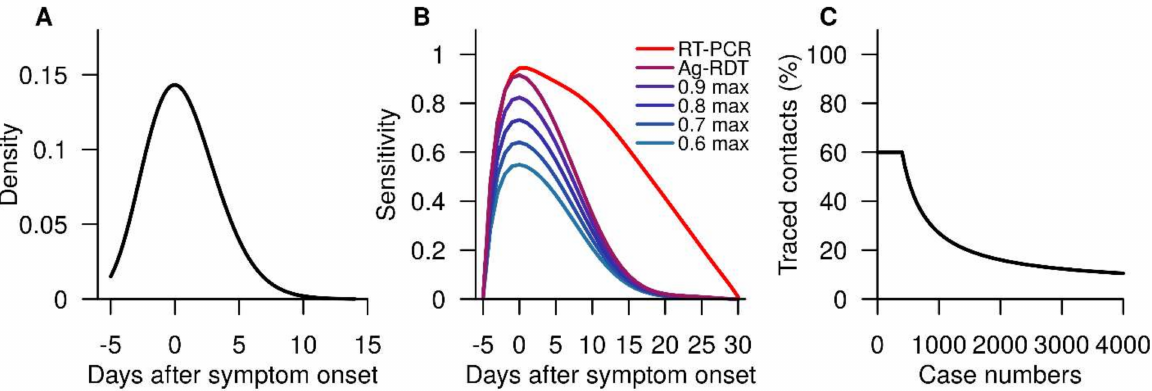
Figure 1. Figures of some parameters used within GeoDEMOS-R. ( A ) Infectiousness of an infected individual relative to the day of symptom onset. ( B ) RT-PCR and Ag-RDT test sensitivity profiles. ( C ) Proportion of traced contacts of detected cases, which diminishes as the cases